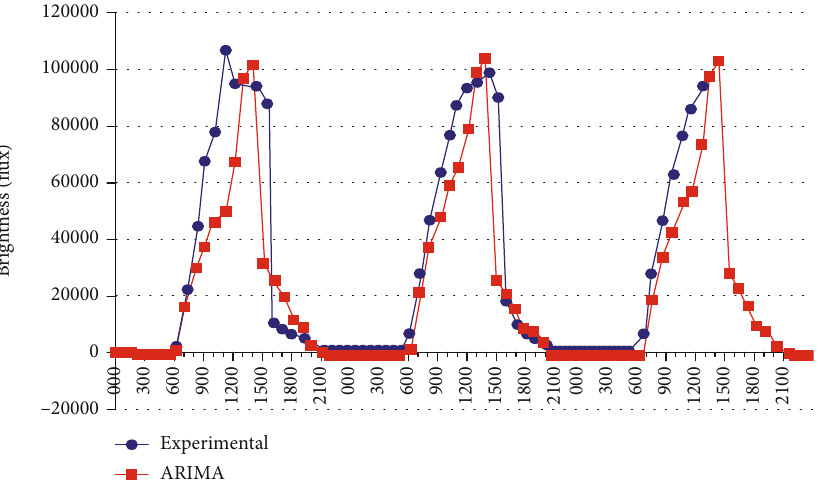
Figure 6: Adjusting the forecasted ANN data with the measured